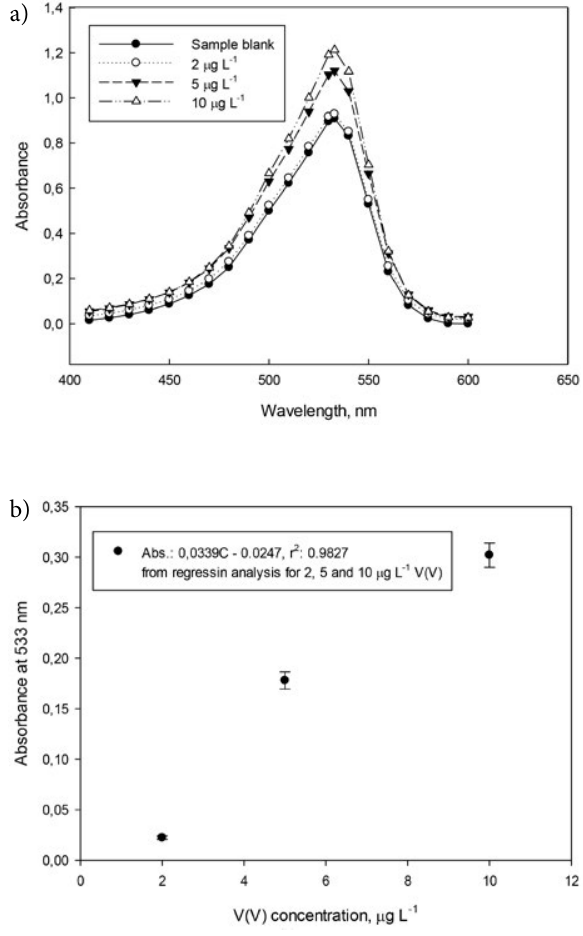
Figure 5. (a) The absorption spectra of the micellar system with increasing V(V) concentration at 2, 5 and 10 µg L –1 plus sample blank as a function of measurement wavelength (nm), λ linearity fit of the micellar system between V(V) concentration in range of 2–10 µg L –1 and absorbance corrected against sample blank at 533